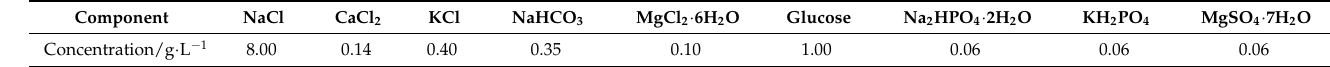
Table 2. Composition of the simulated body